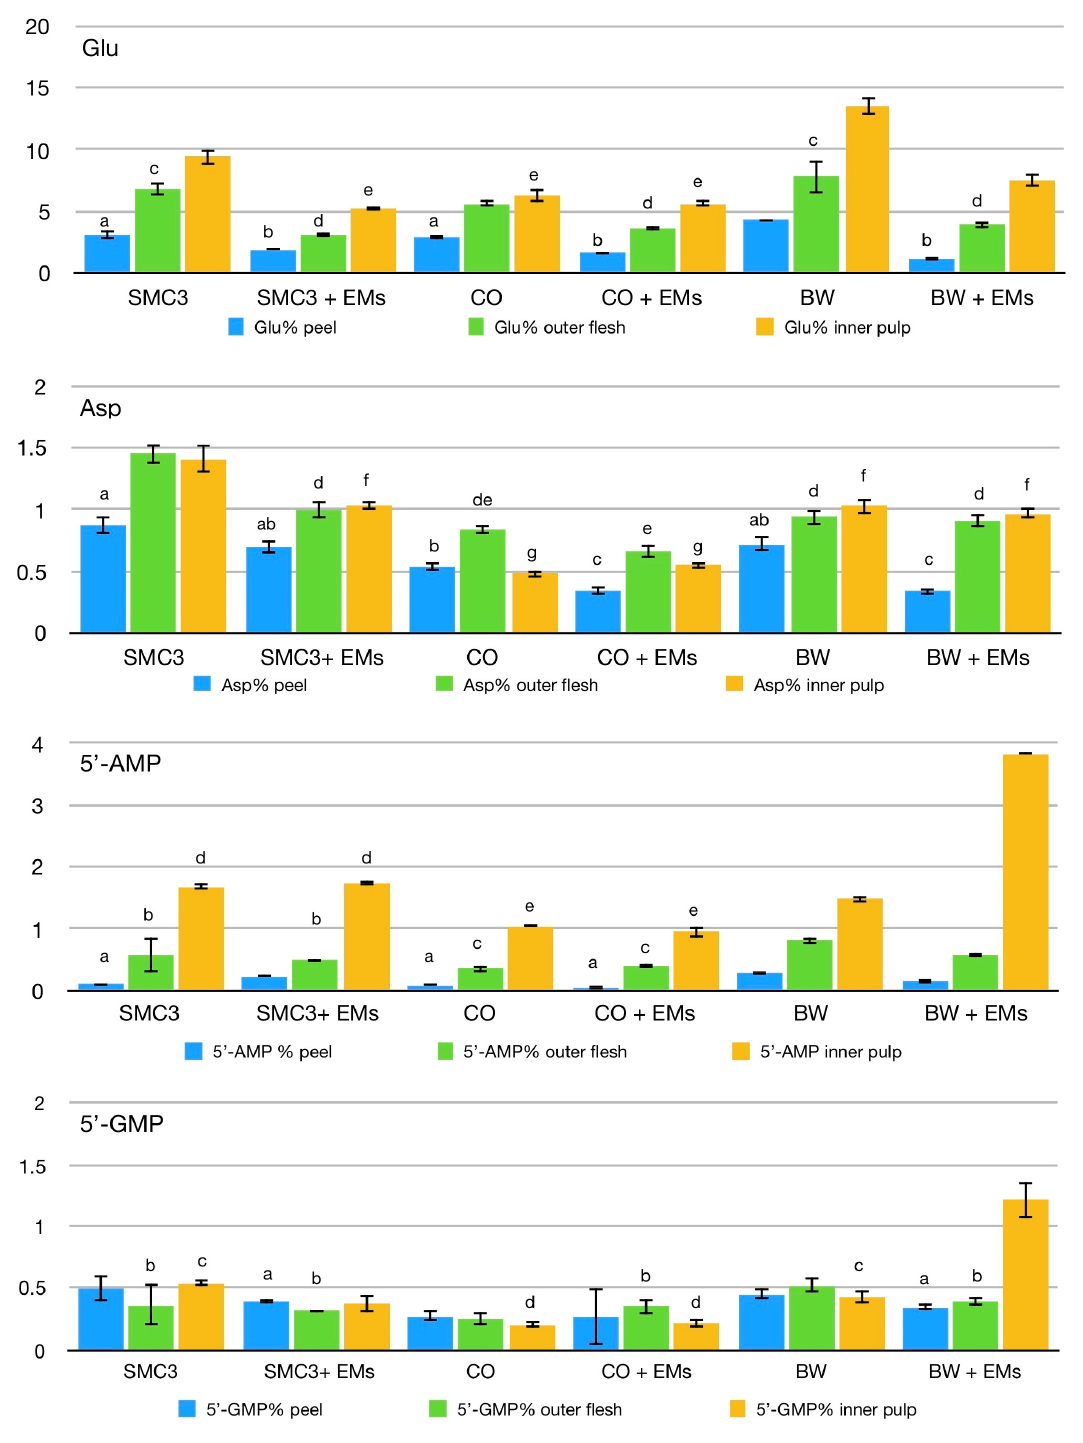
Figure 1. Glutamic acid, aspartic acid, AMP and GMP contents in tomatoes cultivated using standard methods and EM technology. The average values of the three independent measurements are reported; bars marked with the same letter did not show statistically relevant differences at a 95% confidence level after ANOVA analysis and Tukey post-hoc test. SMC3: San Marzano Cirio 3; SMC3 + EM: San Marzano Cirio 3 cultivated using EM technology; CO: Corbarino; CO + EM: Corbarino cultivated using EM technology; BW: Brandywine; BW + EM: Brandywine cultivated using EM technology .